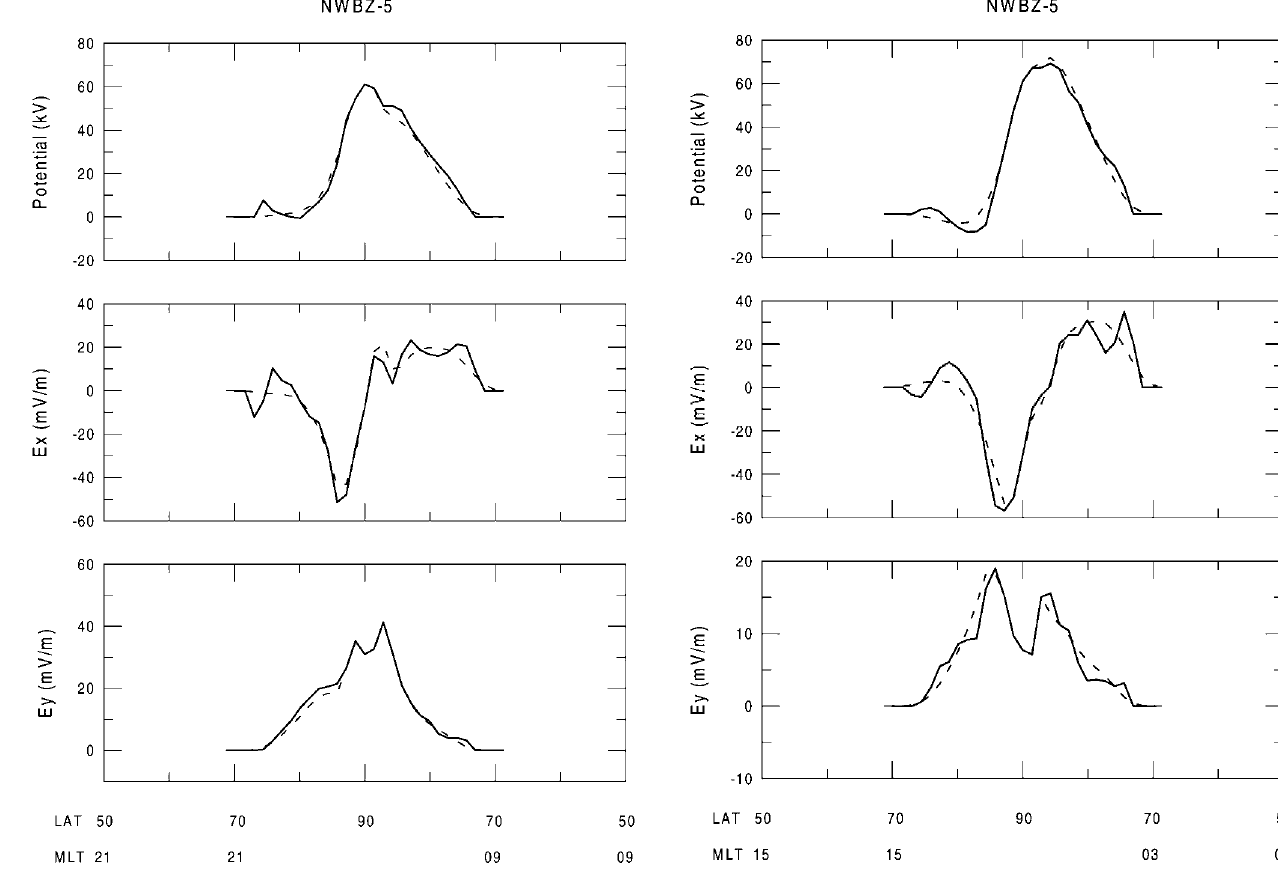
Fig. 3. Profiles of the electric potentials and electric field components ( E x and E y ) in the northern winter polar cap for IMF B x (cid:136) 0, B y (cid:136) 0, B z (cid:136) (cid:255) 5 nT along the MLT meridian 15-03. Solid lines are for the data from the IZMEM/DMSP model, dashed lines represent